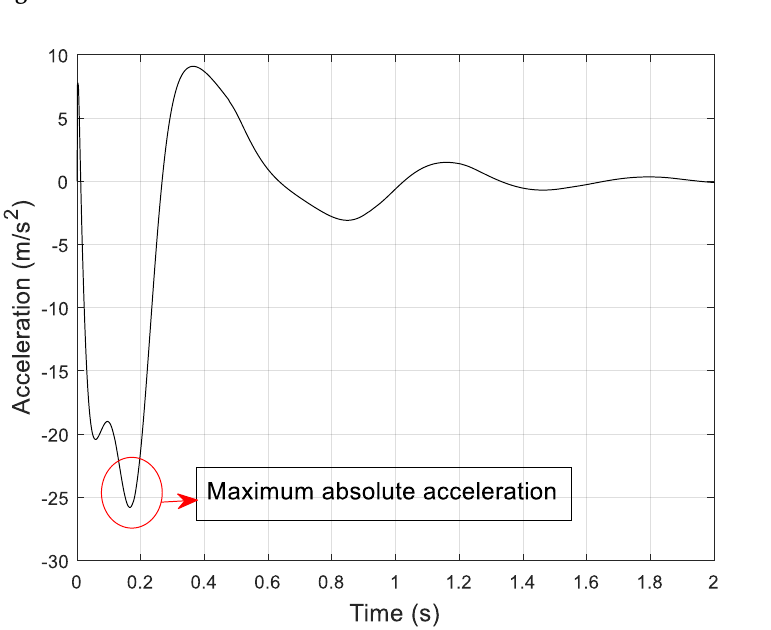
Figure 6. A typical acceleration time history of a helicopter at the center of gravity.